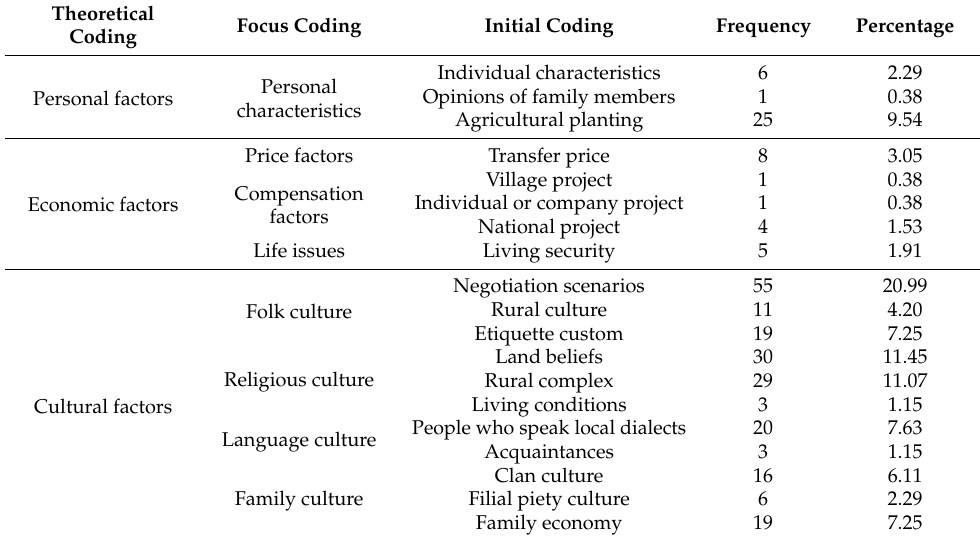
Table 1. Interview data free coding